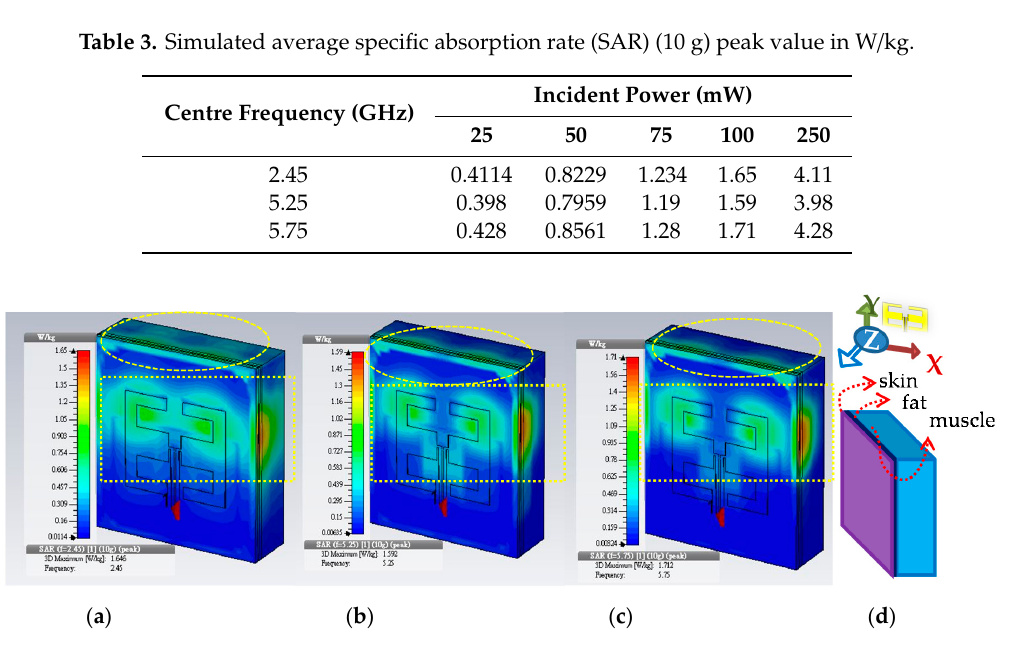
Figure 11. Specific absorption rate (SAR) pattern at 100 mW: ( a ) 2.45 GHz; ( b ) 5.25 GHz; ( c ) 5.75 GHz; ( d ) Custom 3D layer model.